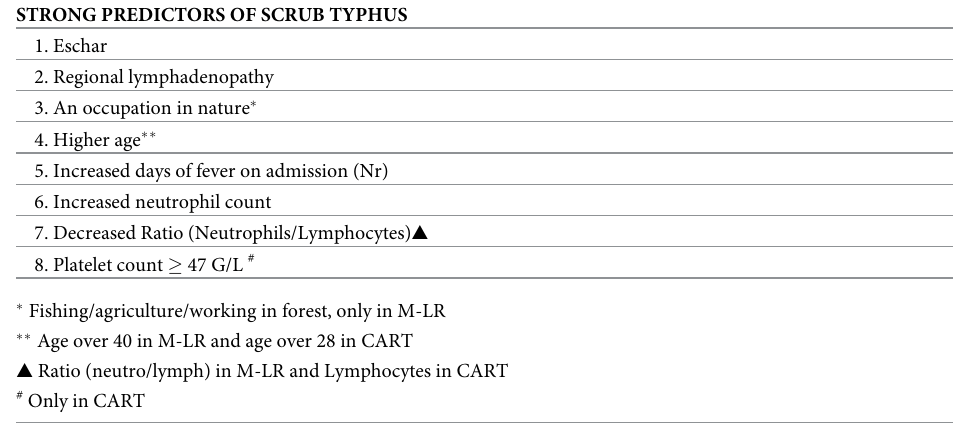
In the CART, the tree included platelet count and age over 28. In the full data set, the index of Youden of the decision tree model (0.681) was almost identical to the one of the regression-based model (Table 4).